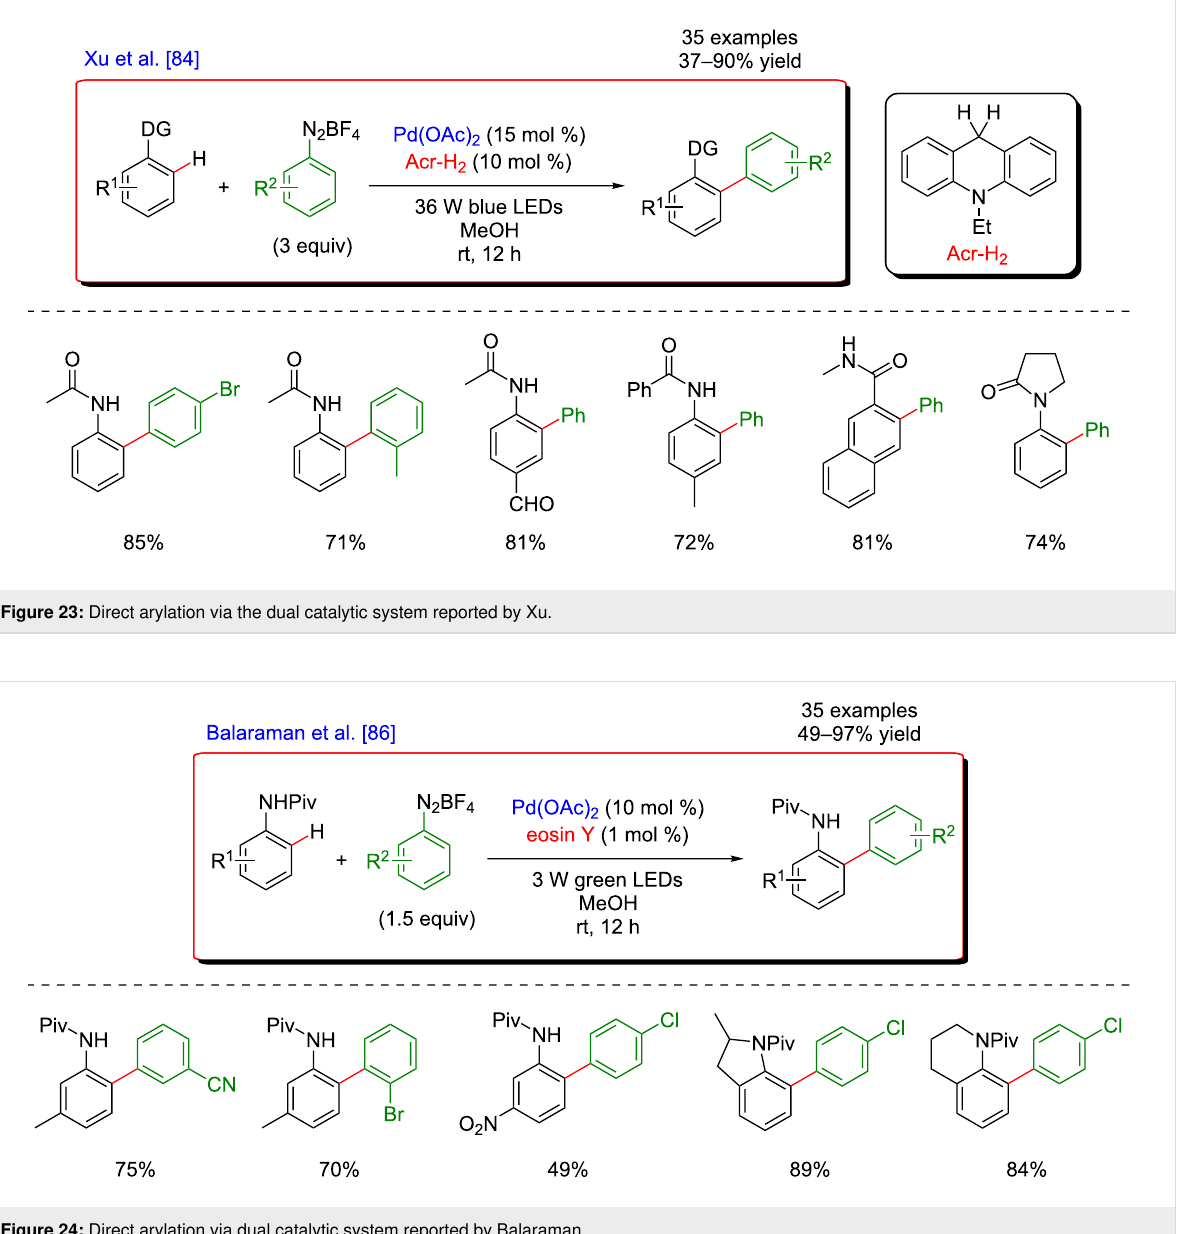
relevant N -heterocyclic compounds such as phenanthridine, carbazole, and dibenzo[ b,d